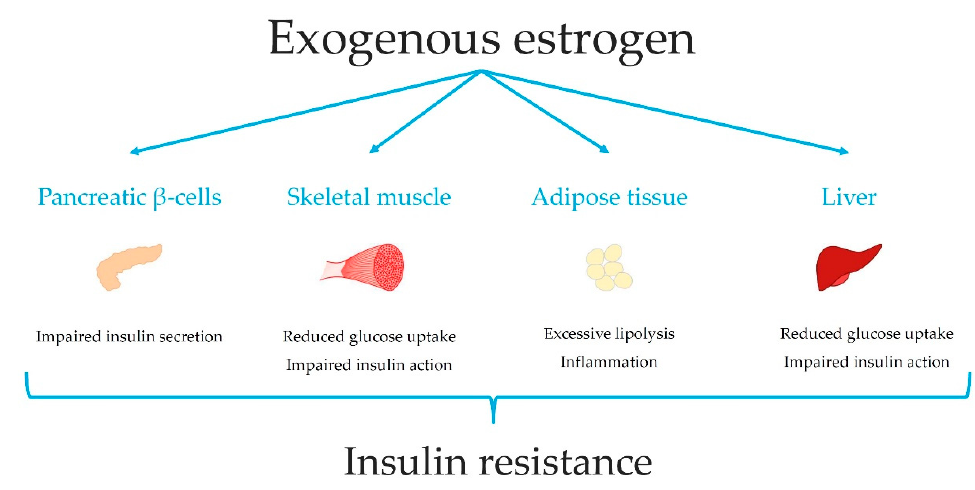
Figure 2. Estradiol ‐ induced insulin